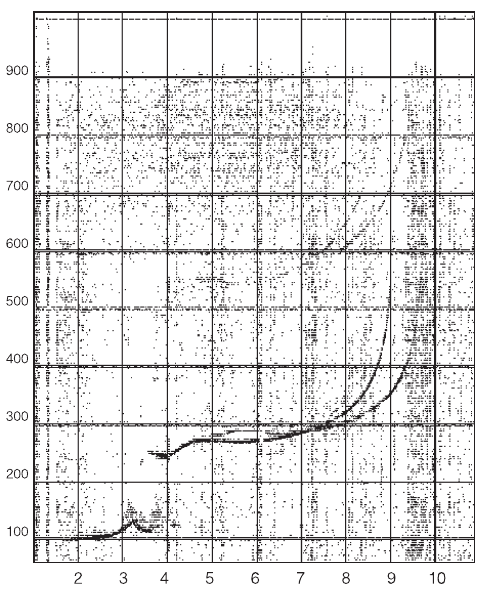
Fig. 4c. Ionogram recorded at 7 a.m. 2002/5/29: other analog